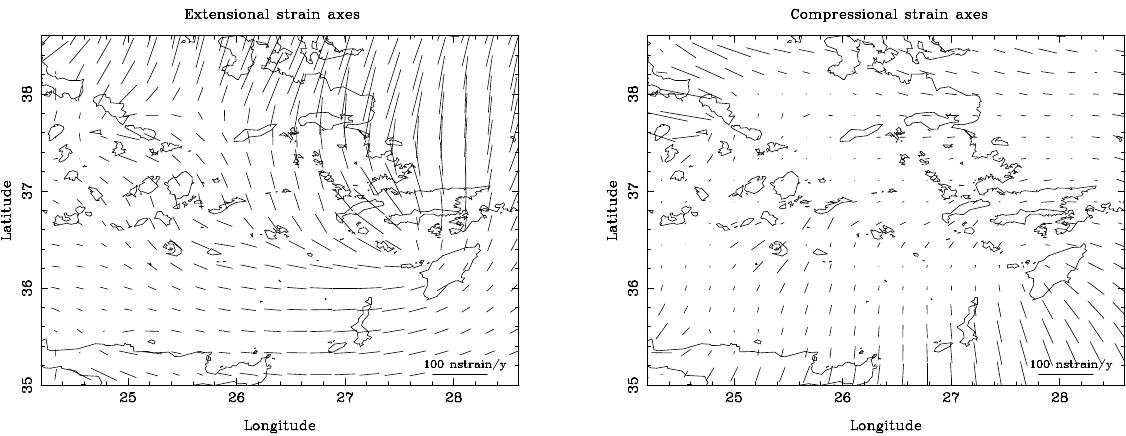
Fig. 13. Extensional (left) and compressional (right) principal directions of strain rate derived from a continuous interpolation of observed GPS velocities in the Aegean (Floyd et al., 2010).